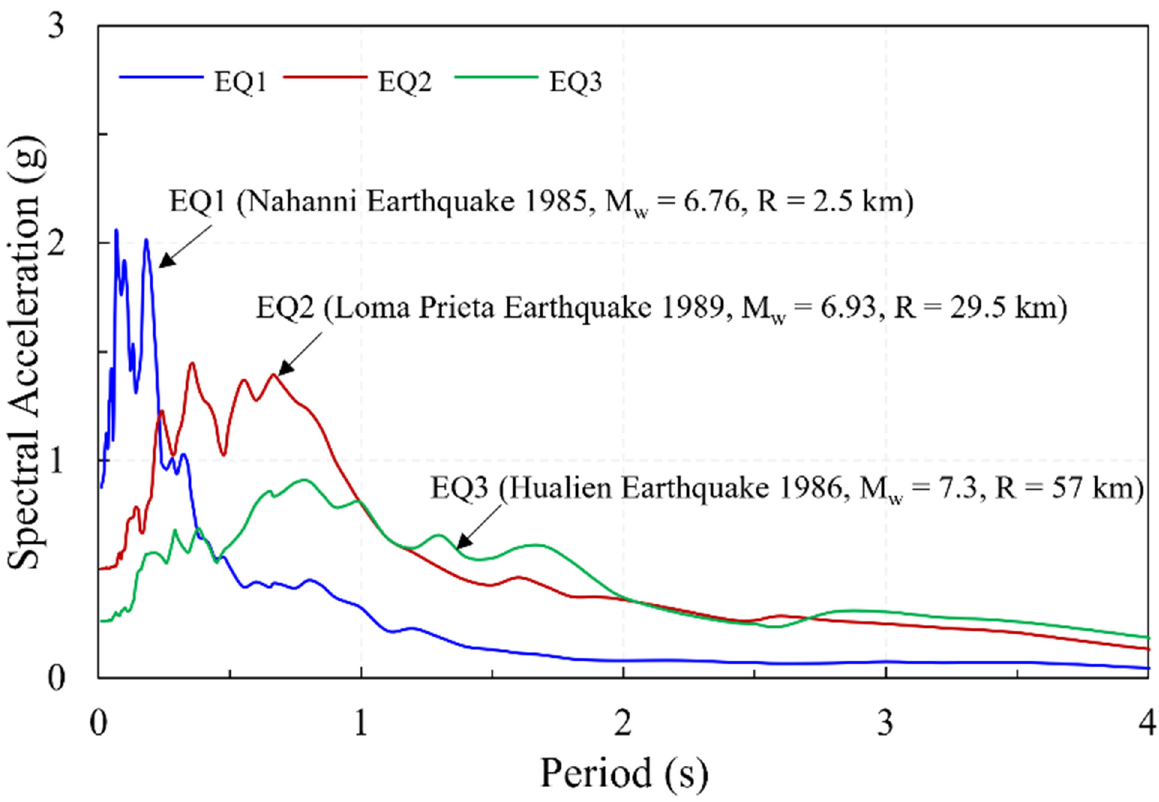
Figure 15. Response spectra of the selected ground motions with 2.5% damping ratio.